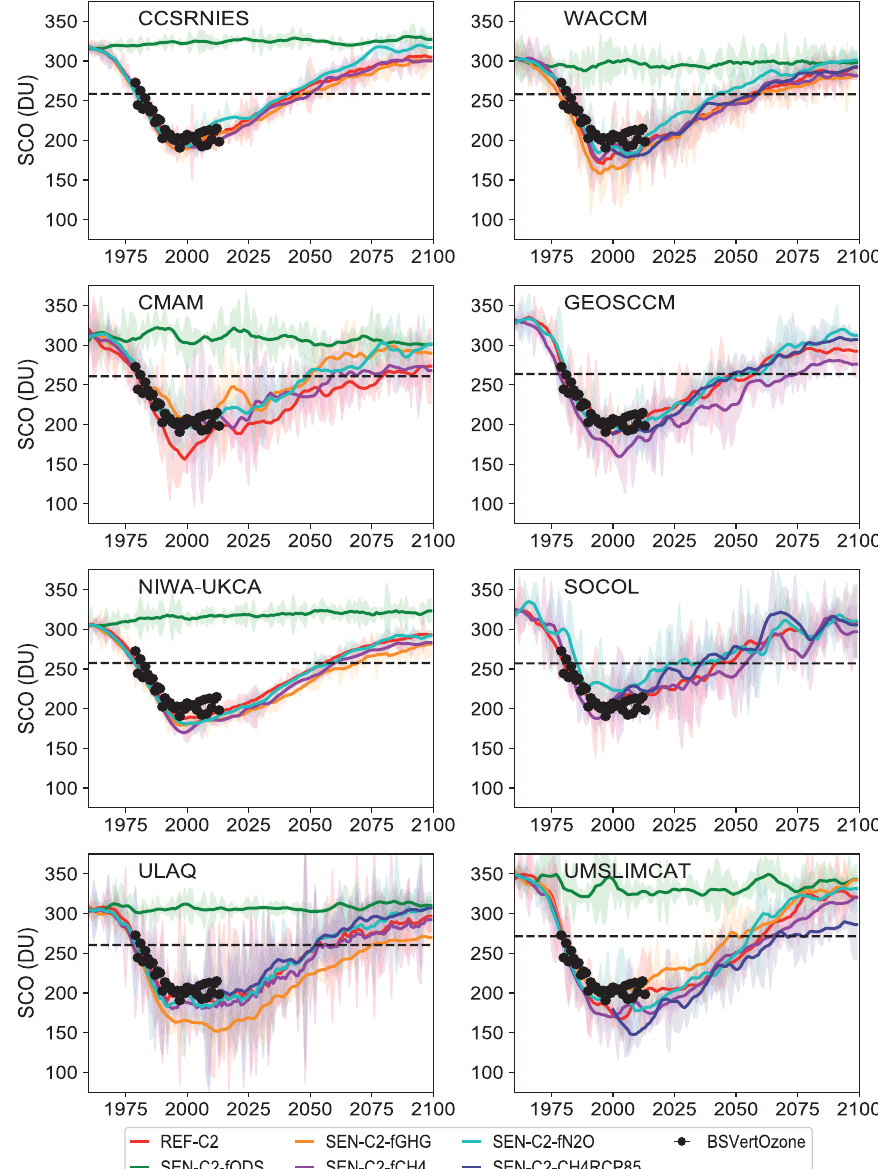
Figure 13. Evolution of Antarctic October mean stratospheric column ozone (DU) from 8 selected models for the REF-C2, SEN-C2-fCH4, SEN-C2-fN2O, SEN-C2-fODS, SEN-C2-fGHG, and SEN-C2-CH4RCP85 simulations. Each panel gives the name of the model shown. The solid lines are the 10-year-smoothed SCO for a given simulation. The shading on the lines shows either the standard deviation from an ensemble of realisations from that model, or the deviation from a three-box smoothed line if only one realisation is available. Note that not all models have performed all simulations. Also shown in each panel is the SCO derived from BSVertOzone data (filled black